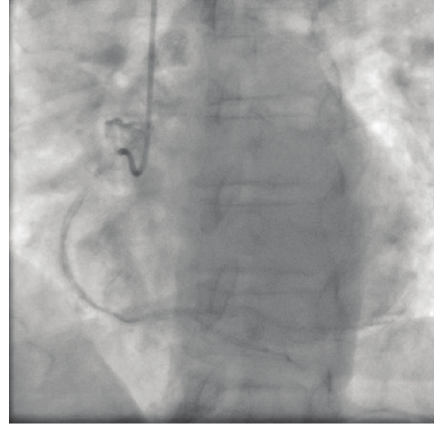
Figure 2: Nonselective injection of RCA.